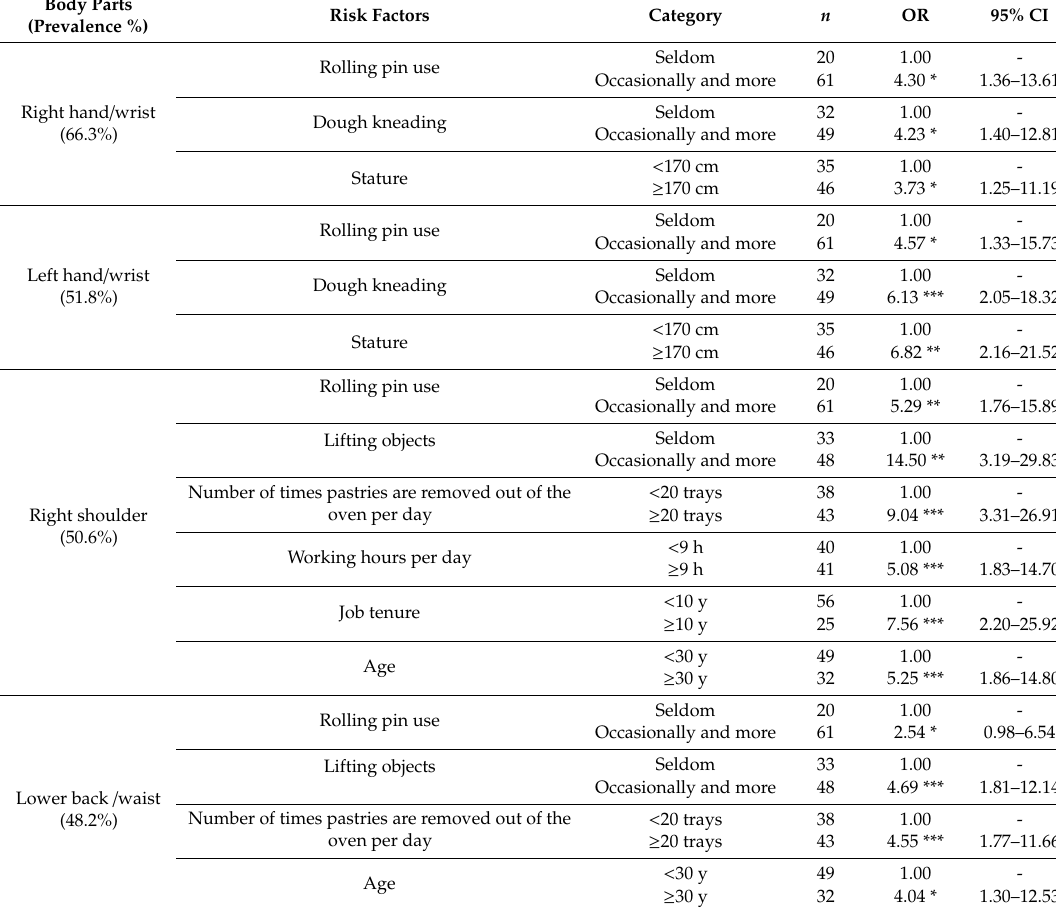
Table 2. Risk factors significantly associated with musculoskeletal